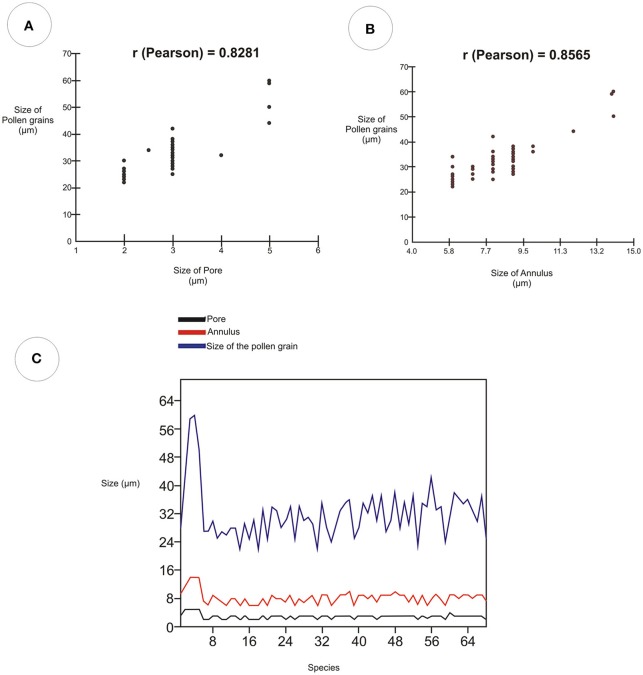
Pearson correlation diagram showing the strength of the relationship between pore, annulus, and size of pollen grain for the 68 Poaceae species. (A) Correlation between the variable sizes of the pore and size of the pollen grain. (B) Correlation between the variable annulus sizes and the pollen grain sizes. (C) Linear chart of the values of the diameters of the pores, annulus, and pollen grains.